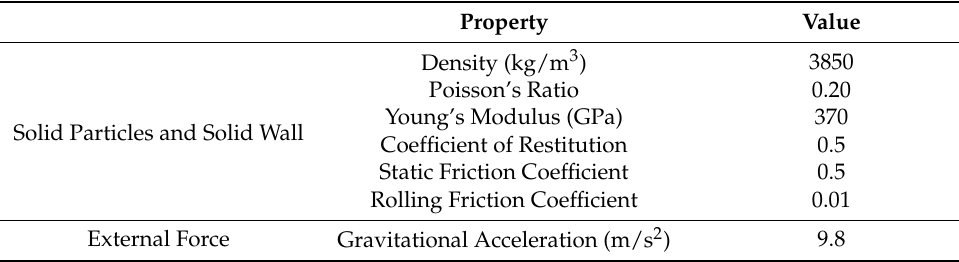
Table 1. Defined property values for alumina particle DEM simulations.